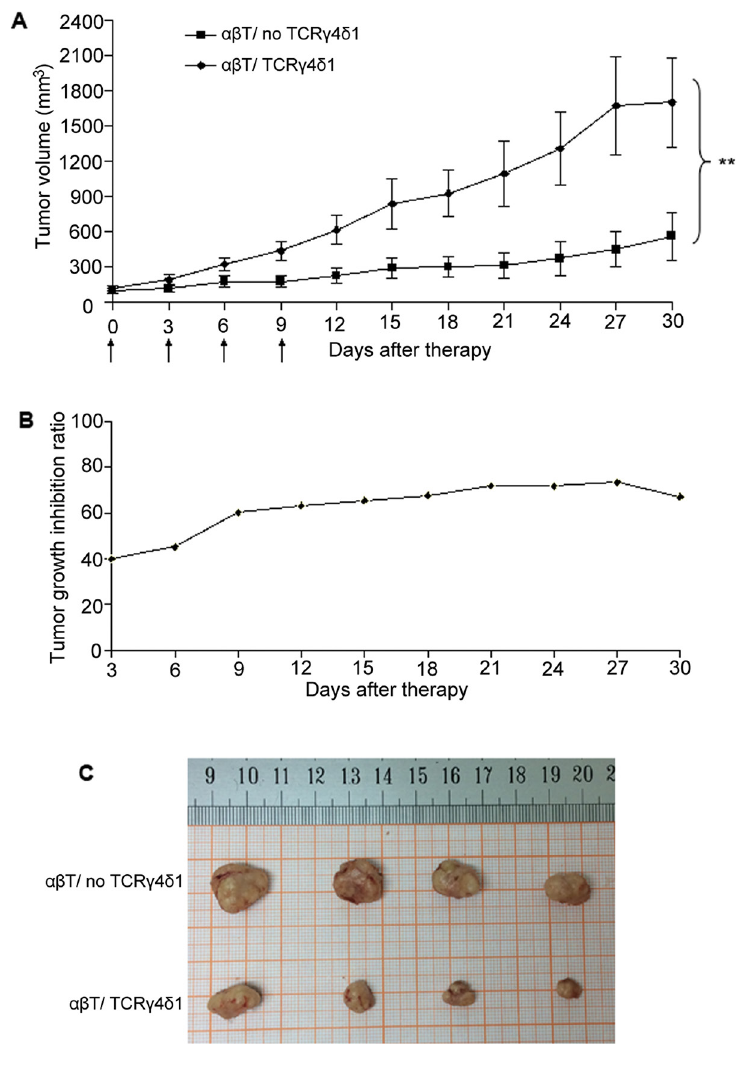
Figure 5. Antitumor activity of TCR g 4 d 1 -engineered αβ T cells in vivo. Mice were subcu- taneously injected with 2 × 10 6 HepG2 cells in the rear right flank. When tumor volume reached approximately 100 mm 3 , mock- and TCR g 4 d 1 -engineered αβ T cells were injected intratumorally every 3 d a total of 4 times, and the tumor volume in the right flank of each mouse was measured every 3 d until 30 d. (A) Mice treated with TCR g 4 d 1 -engineered αβ T cells exhibited significant suppression of tumor volume compared with mice treated with mock-engineered αβ T cells ( P = 0.001). Black arrows indicate the treatment time; each point represents the mean ± SEM, **, P < 0.01. (B) The tumor growth inhibition ratio was estimated. (C) Image of the excised tumors in the experiment evaluating the influences